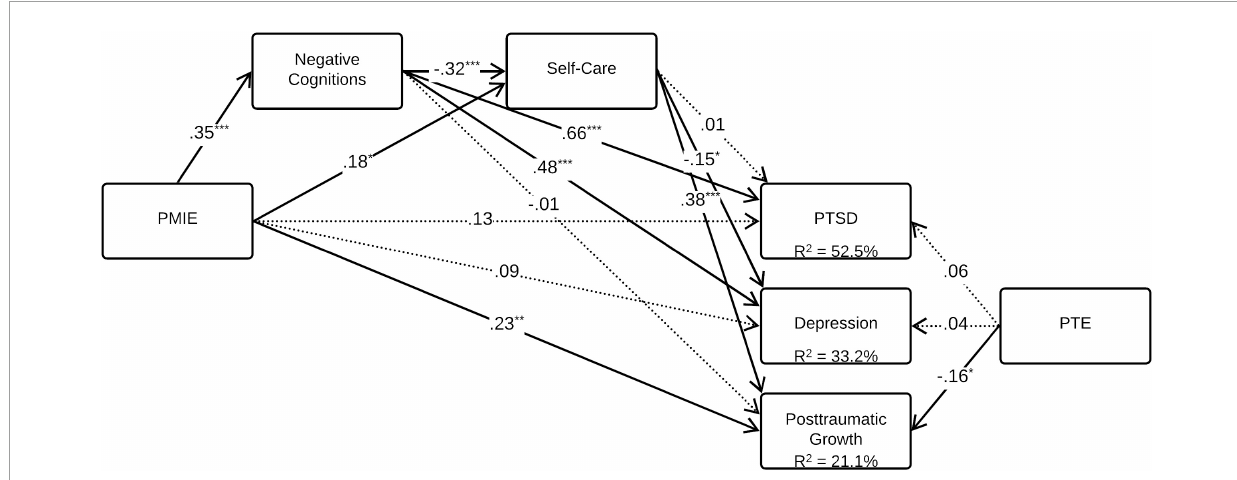
FIGURE2 Estimated model for the effect of PMIE on PTSD symptoms, depression symptoms, and posttraumatic growth, after accounting for PTE. All coefficients are standardized. Significant paths are represented by continuous lines and non-significant paths are represented by dotted lines. Numbers under the three mental health indicators indicate the amount of variance explained (R 2 ). PMIE, potentially morally injurious events; PTSD, posttraumatic stress disorder; PTE, potentially traumatic events. * p < 0.05, ** p < 0.01, *** p < 0.001.